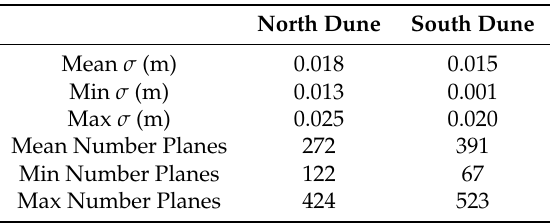
Figure 4. Data acquisition and processing routine for generating Digital Elevation Models (DEMs) used for analysis. Table 1. Point cloud coregistration